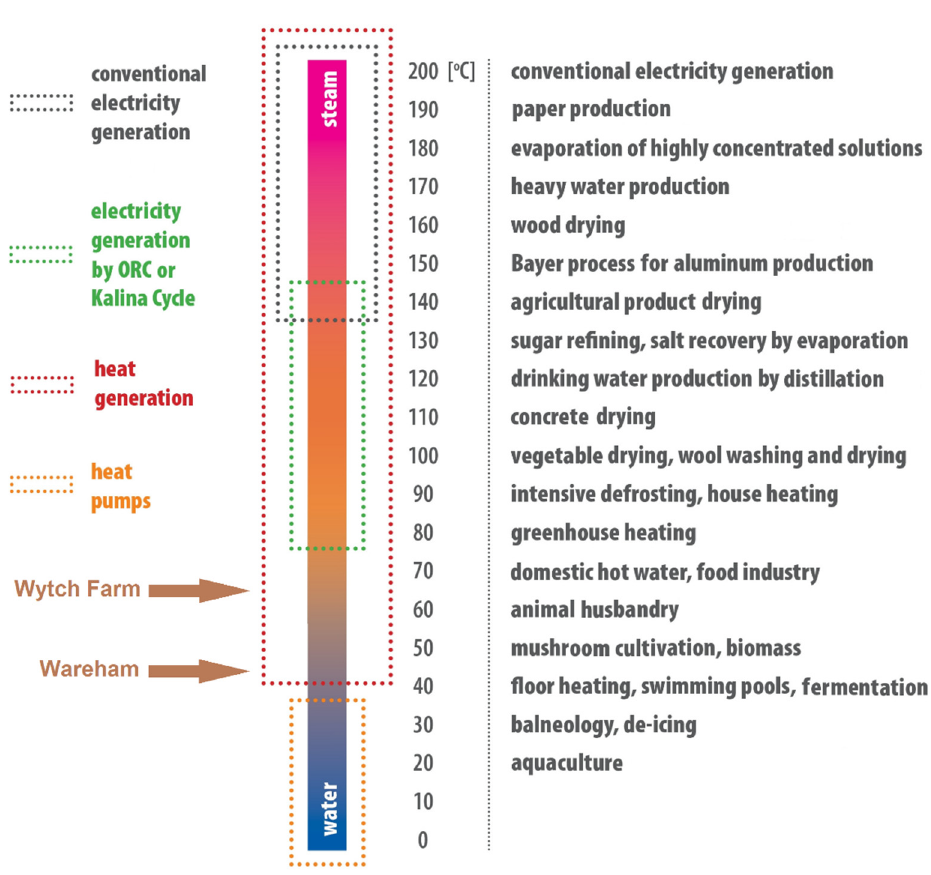
Figure 1. Modified Lindal diagram showing applications for geothermal fluids as a function of their temperature, modified after [17]. ORC denotes the Organic Rankine Cycle. The arrows on the left indicate the low temperature range of interest for the sites analysed in this study.